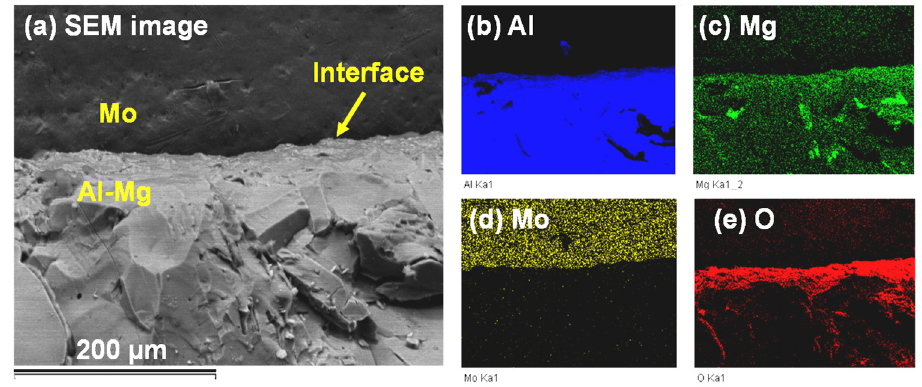
Figure 13. SEM imaging at the interface between the Mo block and the molten Al ‐ Mg alloy after the ALCAN standard immersion test showing ( a ) separation of Mo from the Al ‐ Mg alloy; with EDX elemental mapping for ( b ) Al; ( c ) Mg; ( d ) Mo; and ( e ) O.